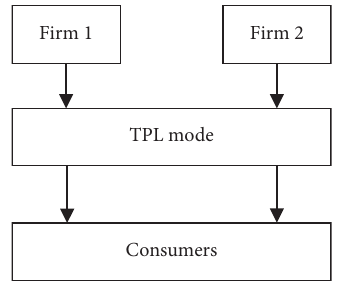
Figure 2: Logistics mode with